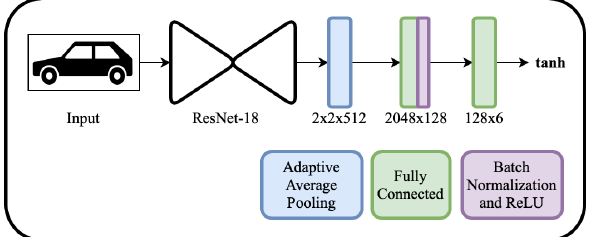
Figure 3. Deep convolutional neural network scheme. We